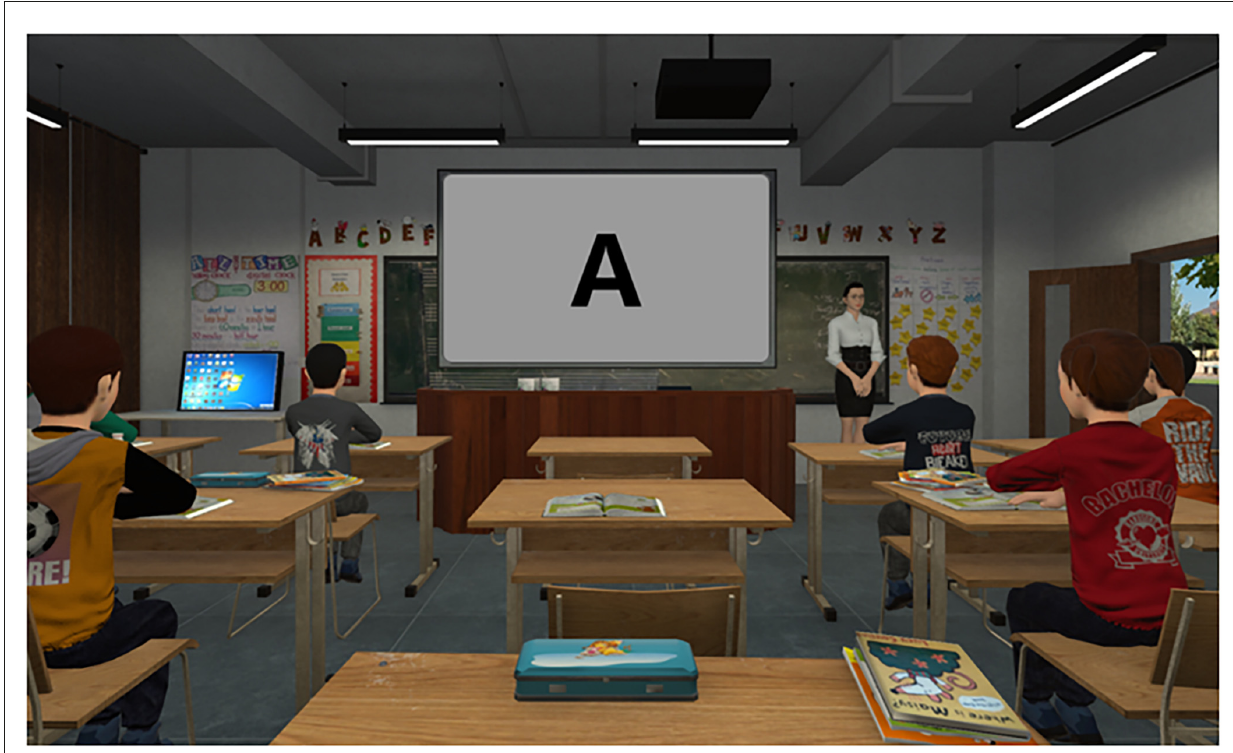
FIGURE1 Screenshot of Virtual Reality Attention Tracker (VRAT)